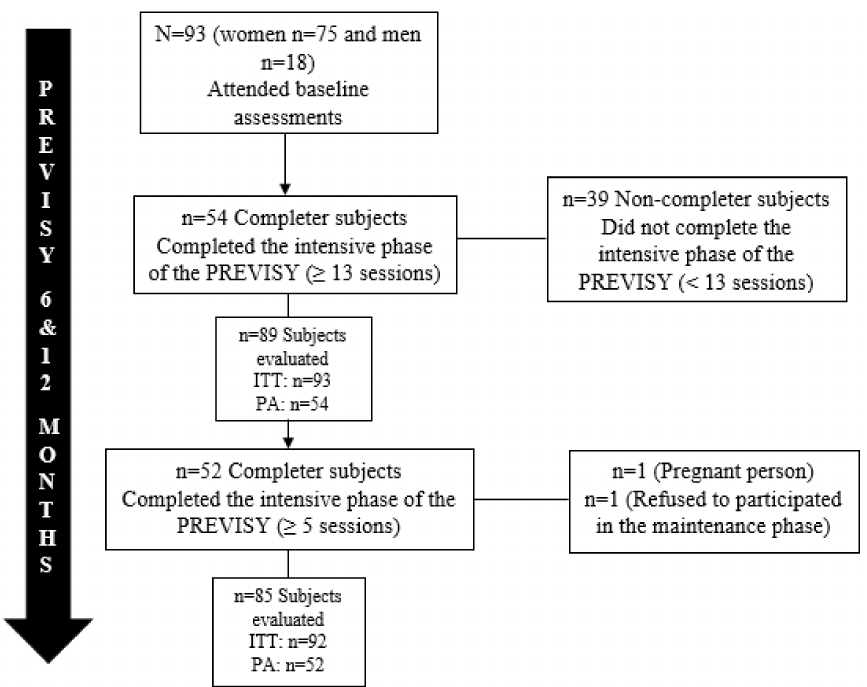
Figure 1. Participation of the subjects in the intensive and maintenance phase of the PREVISY. ITT: intention-to-treat analysis; PA: protocol